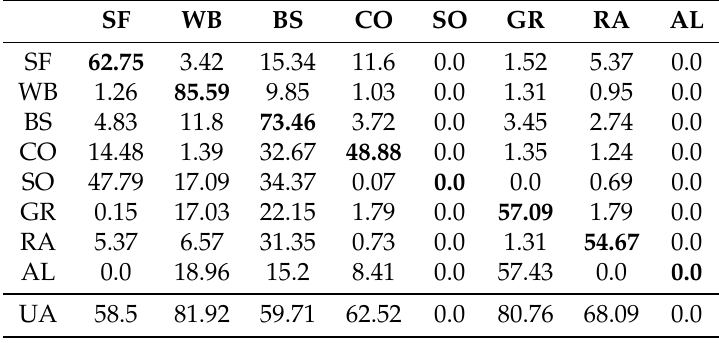
Table 9. Confusion matrix for 24-03-2015 using Sentinel-1 (5 images). κ = 0.61.